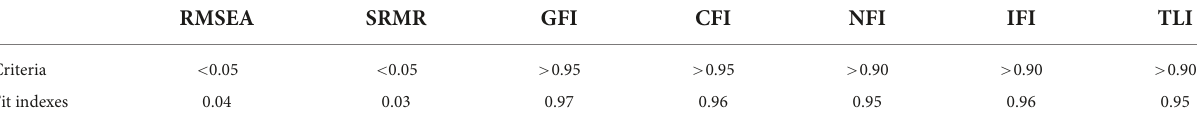
TABLE 5 Confirmatory factor analysis model fit indexes.